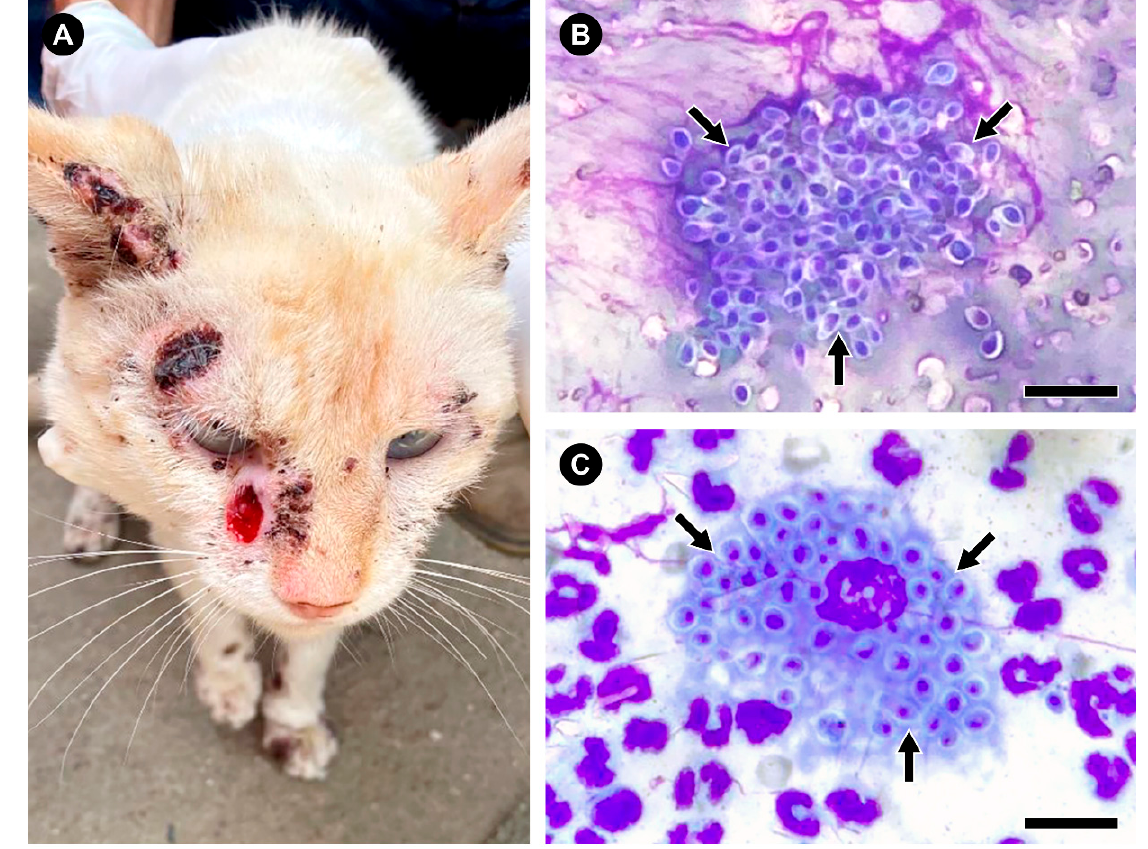
Figure 5. The diagnosis of feline sporotrichosis can employ simple, fast, and inexpensive methods such as the quick Panoptic method. ( A ) Clinical aspect of feline sporotrichosis with ulcerated lesions in the cephalic region of a cat from the state of Espírito Santo, Brazil. ( B , C ) Feline macrophages infected with numerous S. brasiliensis yeasts cells (arrows), stained using the quick Panoptic method. Bar = 15 µm.